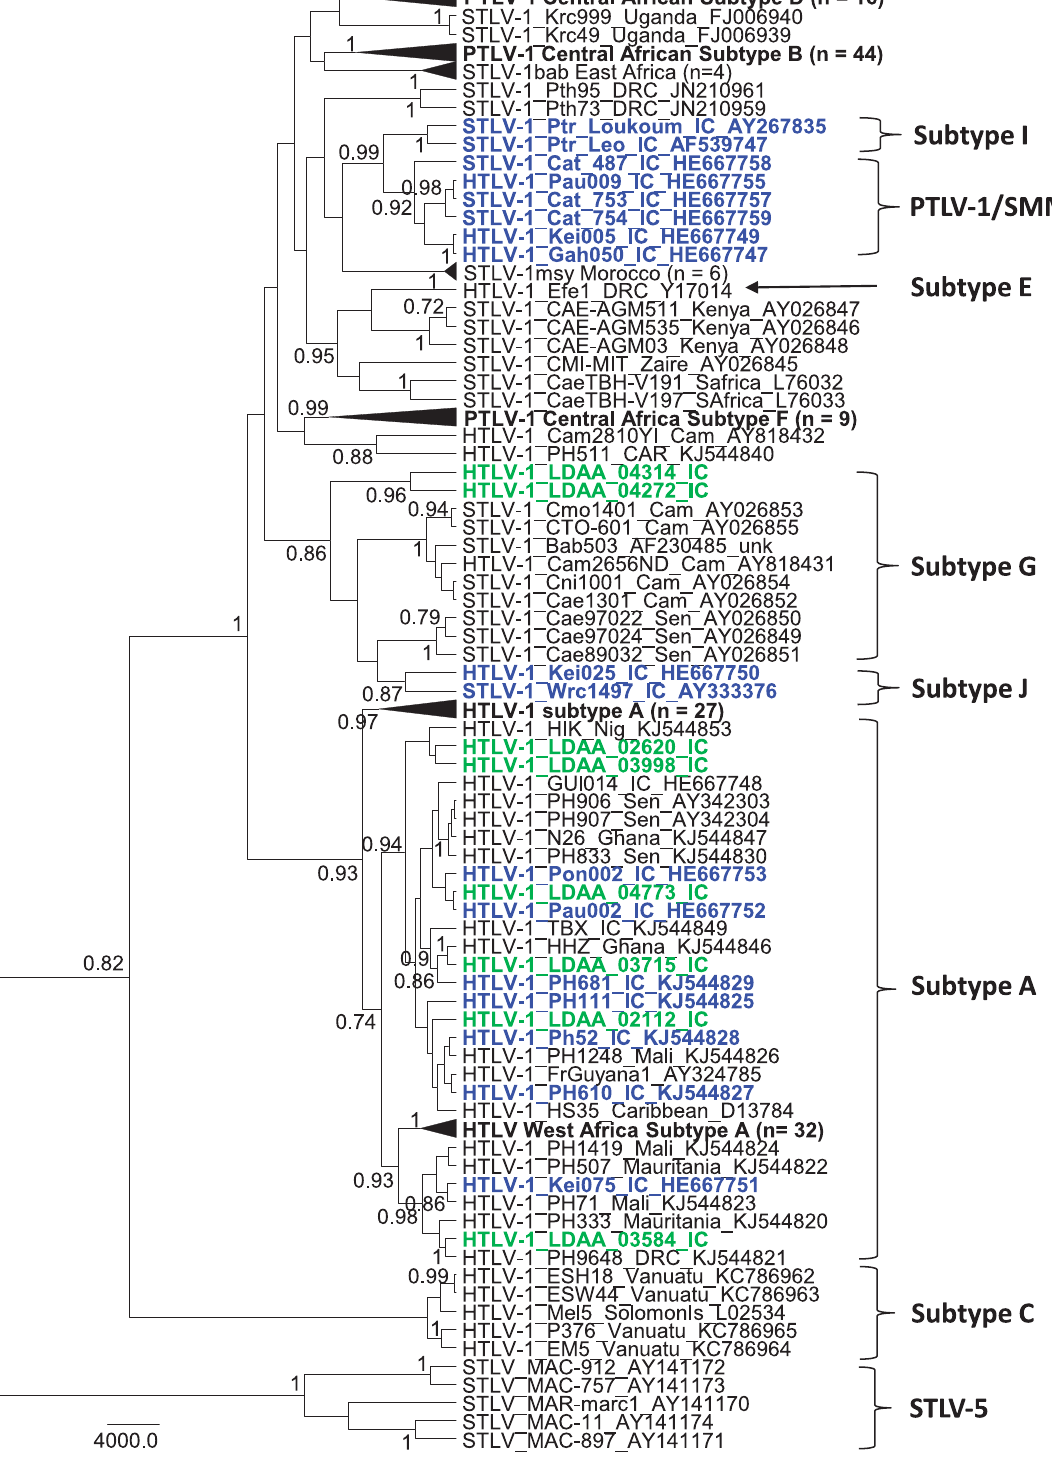
Fig 4. Identification of simian T-lymphotropic virus type 1 (STLV-1)-like viruses in patients from Côte d ’ Ivoire. Bayesian long terminal repeat (LTR) maximum clade credibility tree inferred using an alignment of 1,178 nucleotide positions and 216 global STLV-1 and human T-lymphotropic virus type 1 (HTLV-1) taxa. New LTR sequences created in our study are shown in green text, while those from other studies from Côte d ’ Ivoire are shown in blue text for comparison. Taxa in some